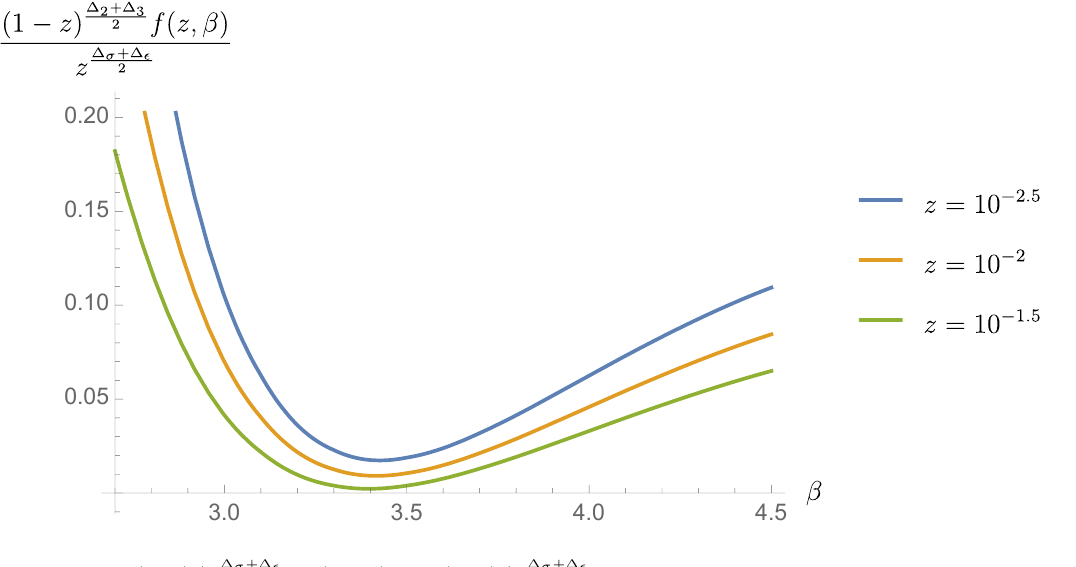
Figure 18 . f ( z, β ) /z ∆ σ +∆ (cid:15) 2 = ( J − 1) C odd ( z, β ) /z ∆ σ +∆ (cid:15) 2 for β close to ∆ σ +∆ (cid:15) +2 for three different values of z . Within errors, this function seems compatible with having a double zero touching the real